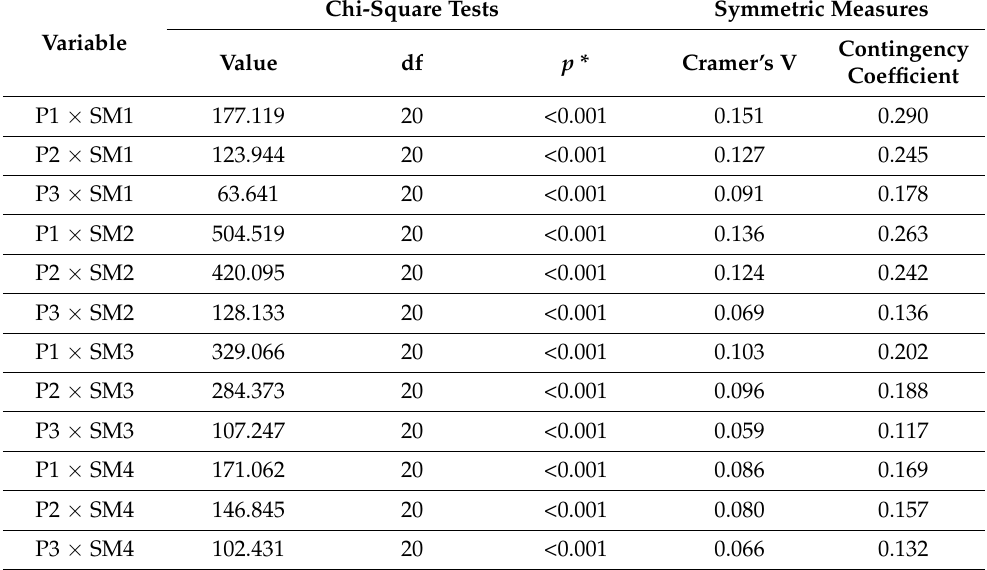
Table 9. Participation vs. Smart Mobility—chi-square tests results.